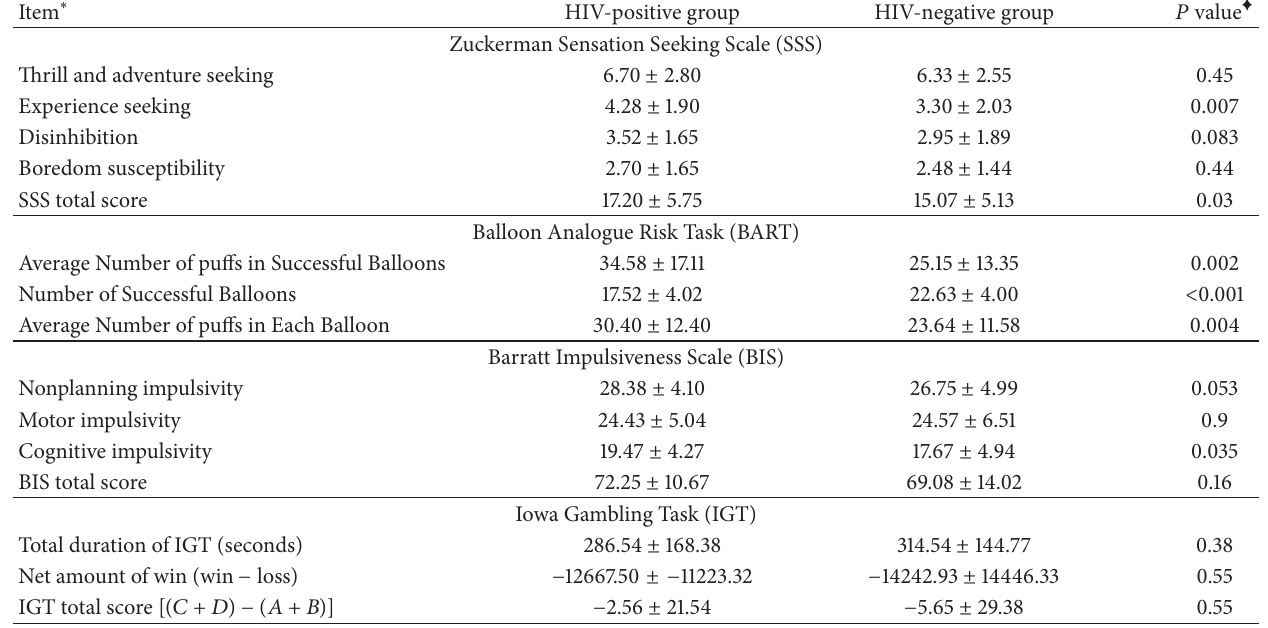
Table 2: Comparison of subscale scores in each test between HIV-positive group and HIV-negative